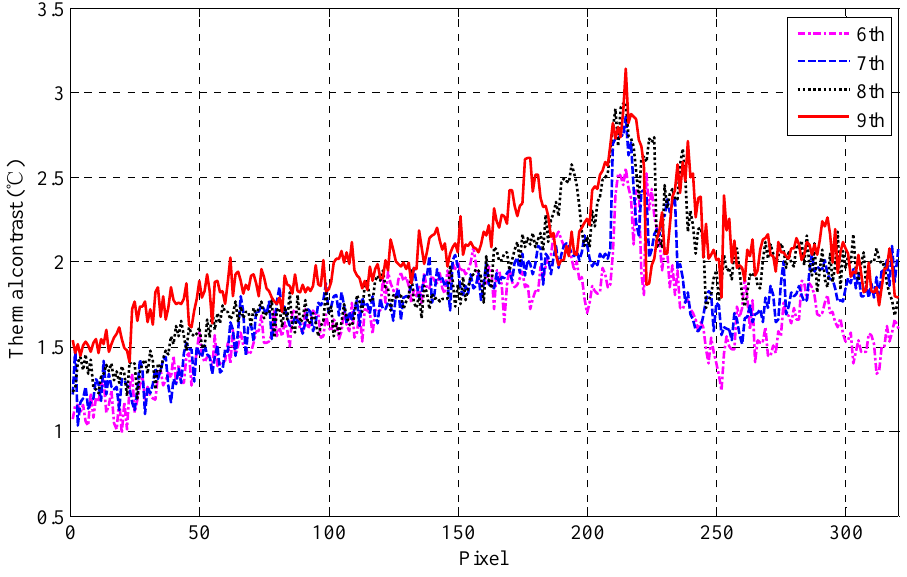
Figure 8. Thermal contrast profile perpendicular to the extension of the crack.